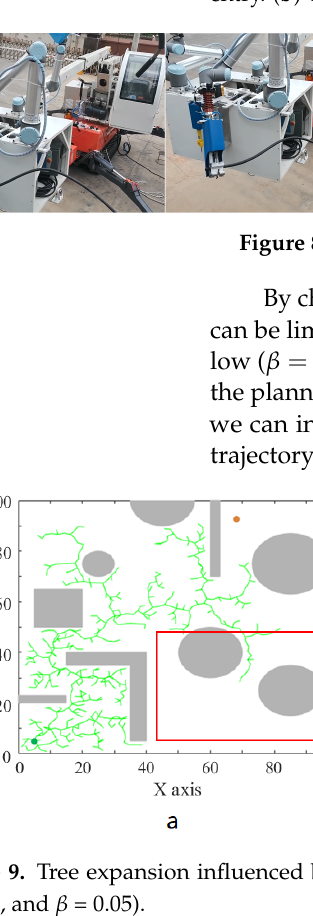
Figure 7. Tool restrictions on robot movement. (( a ) The unfixed parts need to be kept open for cable entry. ( b ) Cable with uncertain twist).